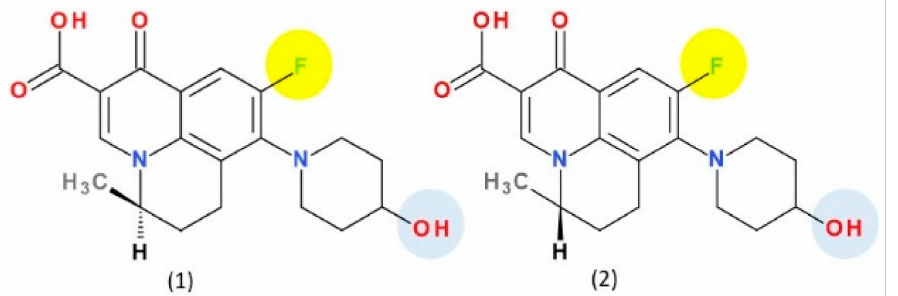
Figure 9. Chemical structures of nadifloxacin ( 1 ) and levonadifloxacin ( 2 ). Levonadifloxacin ((12 S